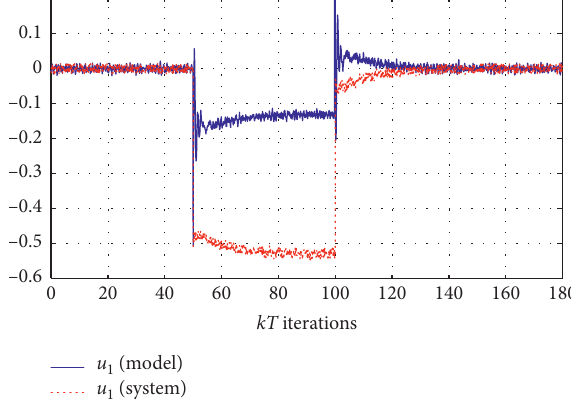
Figure 7: Control signal u